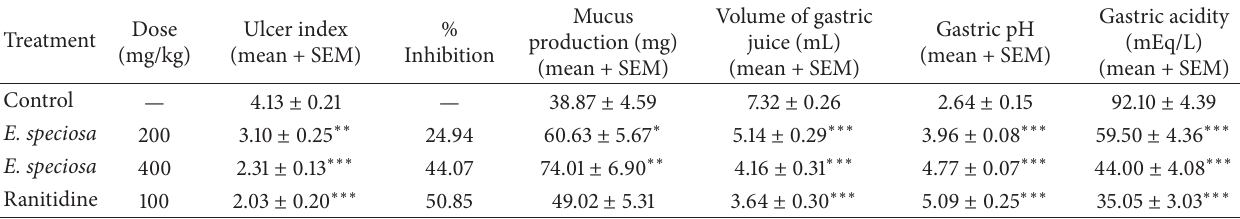
Table 8: Effects of orally administered aqueous extract of E. speciosa on gastric ulceration and secretion in pylorus-ligated rats treated with